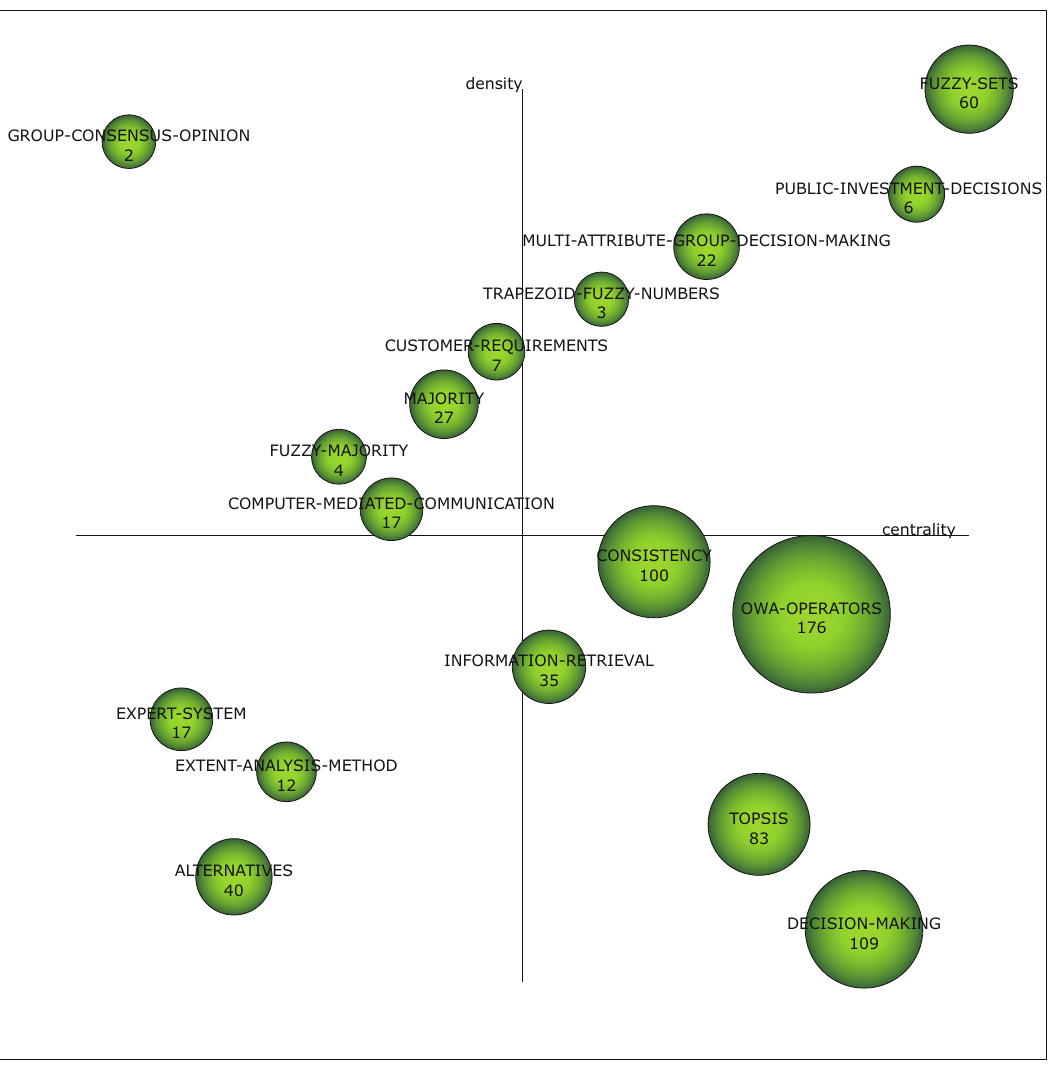
Figure 12. Strategic diagram for the 1991–2009